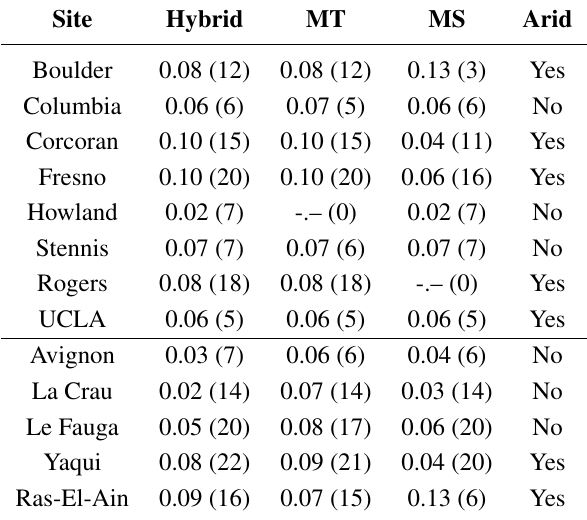
Table 5. RMSE of AOT retrievals at 550 nm obtained using the three different inversion techniques (hybrid, multi-temporal, multi-spectral) with regard to AERONET measurements for different sites. Between parentheses, the number of match-ups available to compute the statistics is